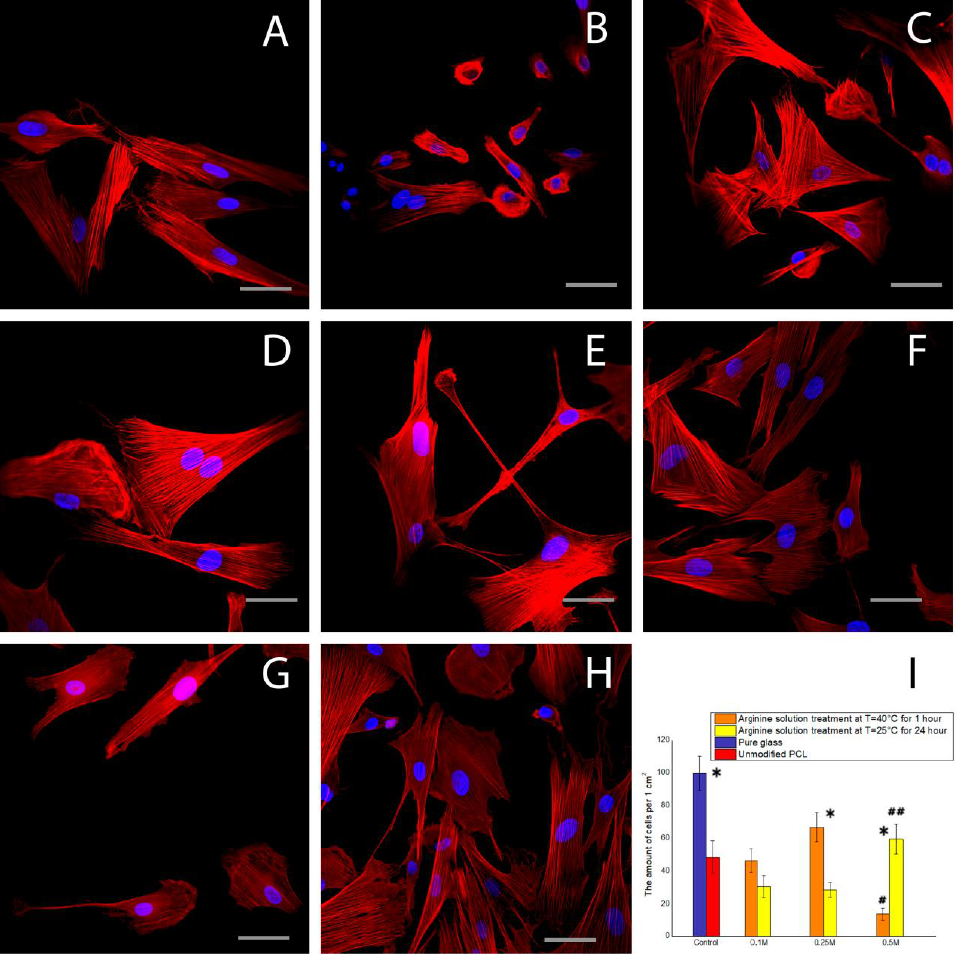
Figure 6. Fluorescence microscopy of the MSC cells after 1 day of cultivation: ( A ) on the pure glass, ( B ) on the unmodified PCL, ( C ) on the film treated with the 0.1 M arginine solution for 1 h at T = 40 °C, ( D ) on the film treated with the 0.25 M arginine solution for 1 h at T = 40 °C, ( E ) on the film treated with the 0.5 M arginine solution for 1 h at T = 40 °C, ( F ) on the film treated with the 0.1 M arginine solution for 24 h at T = 25 °C, ( G ) on the film treated with the 0.25 M arginine solution for 24 h at T = 25 °C, ( H ) on the film treated with the 0.5 M arginine solution for 24 h at T = 25 °C, and ( I ) the dependence of the amount of the MSC cells on the modification conditions after 1 day of cultivation (n = 5: *—p < 0.01 for the same concentration data, #—p < 0.01, ##—p < 0.05 compared with the unmodified PCL). Scale bar 50 µm.